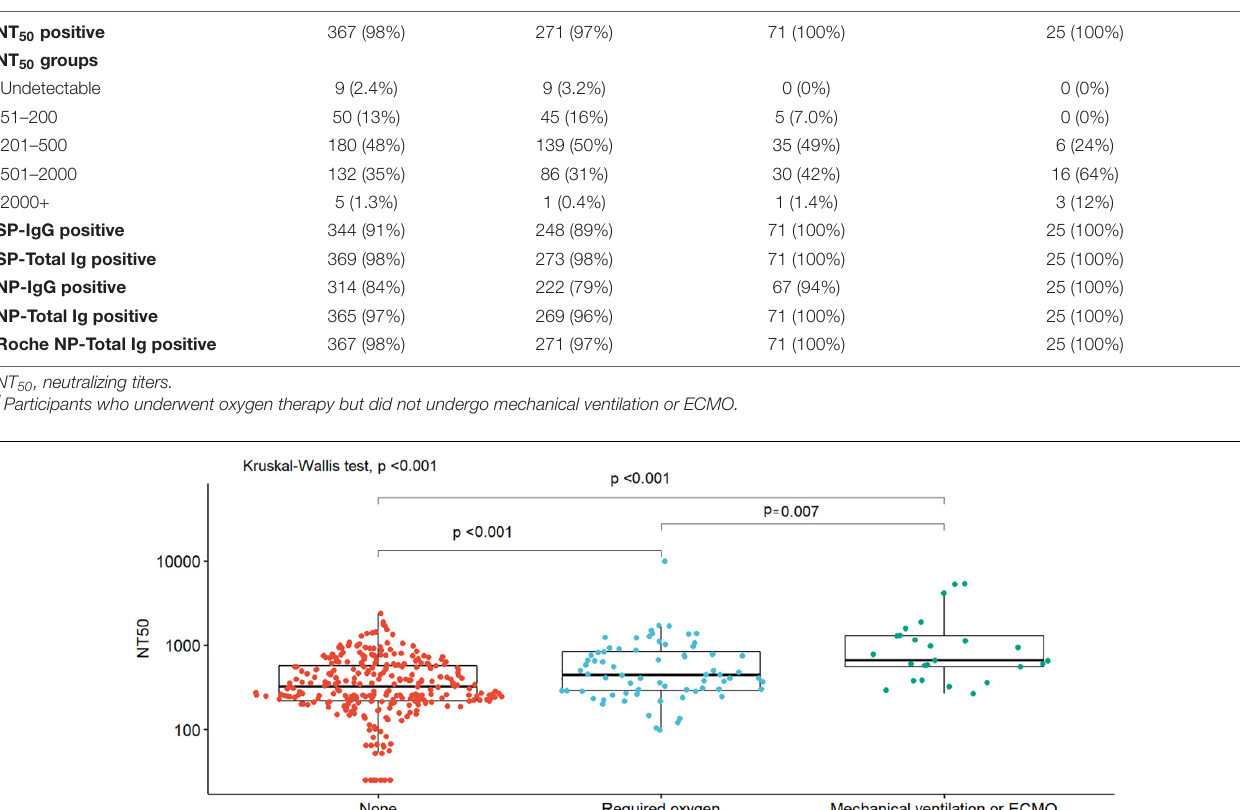
Mechanical ventilation or N = 71 ECMO, N = 25